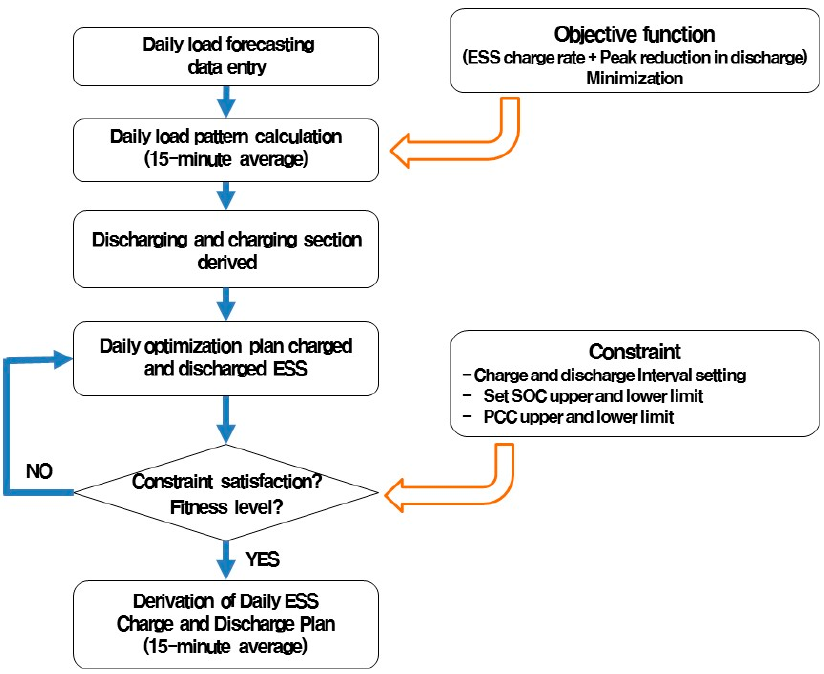
Figure 2. Optimal algorithm of energy storage system (ESS) operation for the peak power reduction system (PPRS).